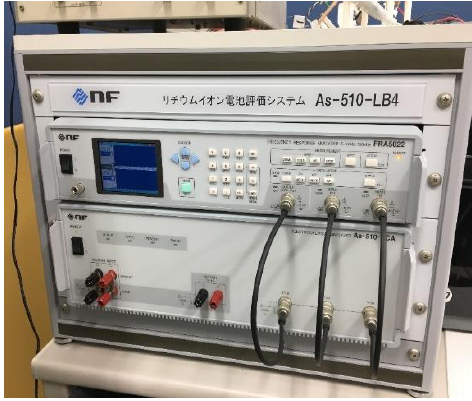
Figure A2. Evaluation system AS-510-LB4.